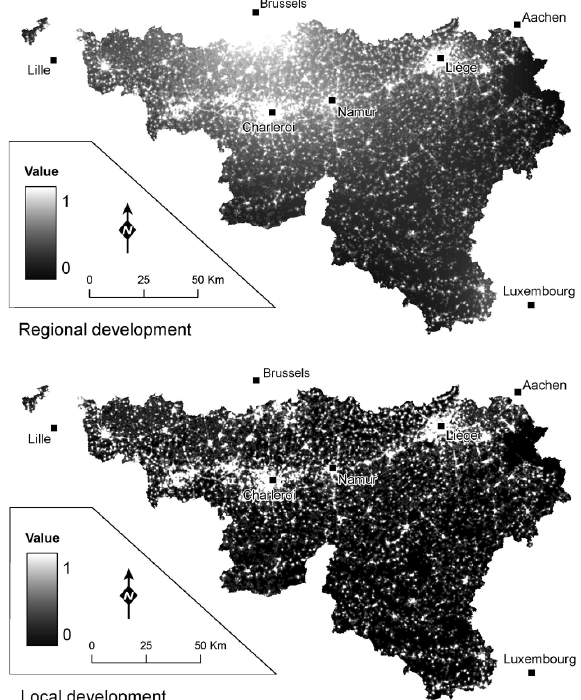
Fig. 10. Potential maps for new residential areas in the Walloon region in the two subsets of dense urban development